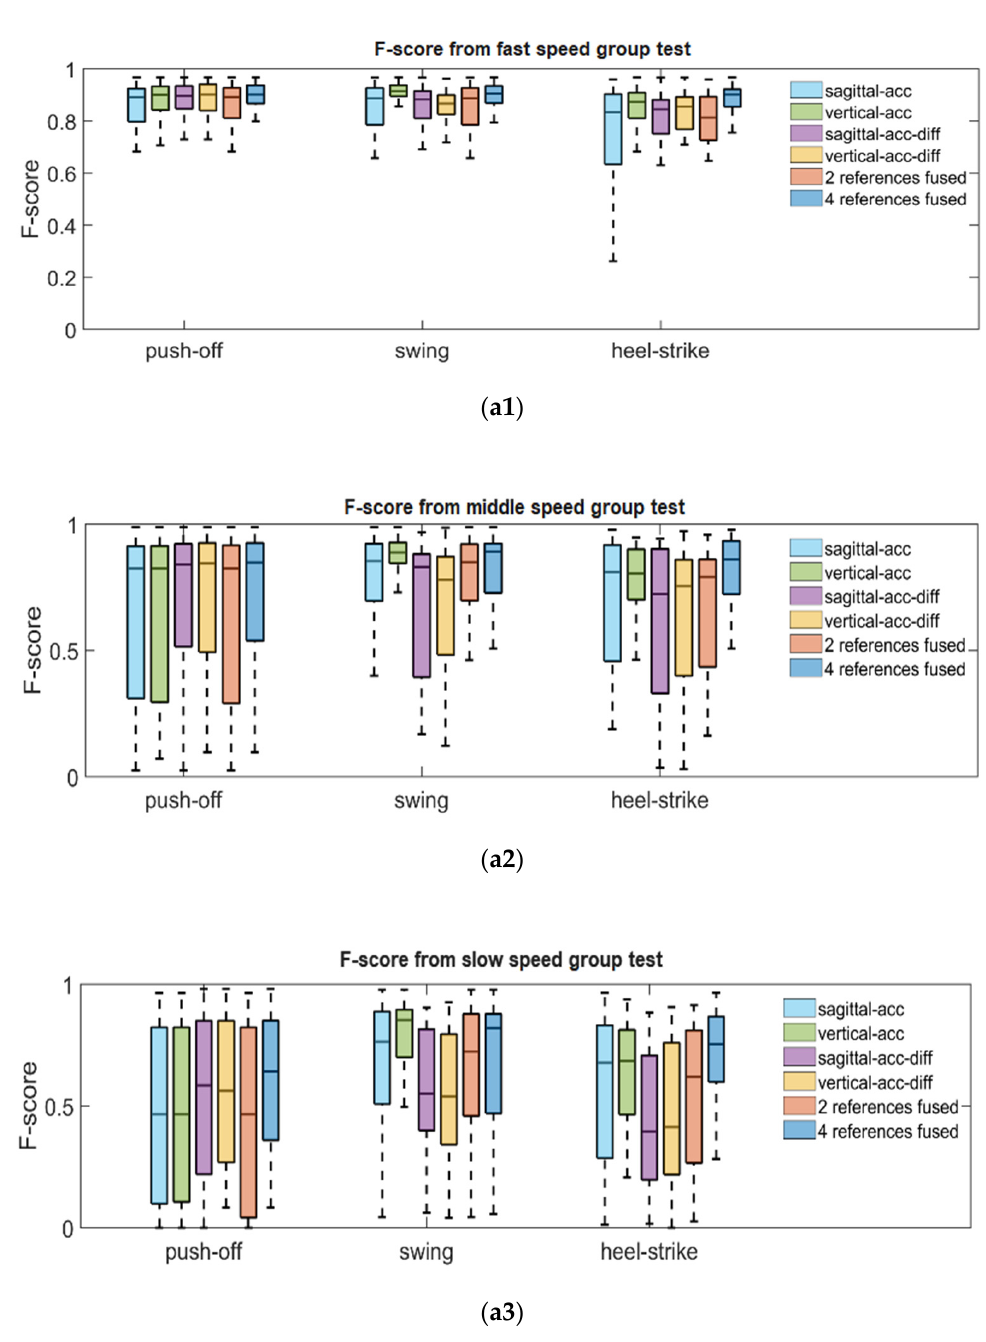
Figure 9. Use F-score as metric to measure the performance of gait segmentation methods for recognizing push-off phases, swing phases and heel-strike phases. Subfigures ( a1 – a3 ) shows the F-score corresponding to three gait phases in walking with fast speed, middle speed and slow speed respectively. The first four items in legend box indicate using only one reference information to detect gait phases boundaries. The ‘2 references fused’ item indicates calculating the average value between ‘sagittal-acc’ and ‘vertical-acc’ as gait boundaries. The ‘4 references fused’ item means the detected boundaries are based on the fusion of all kinds of